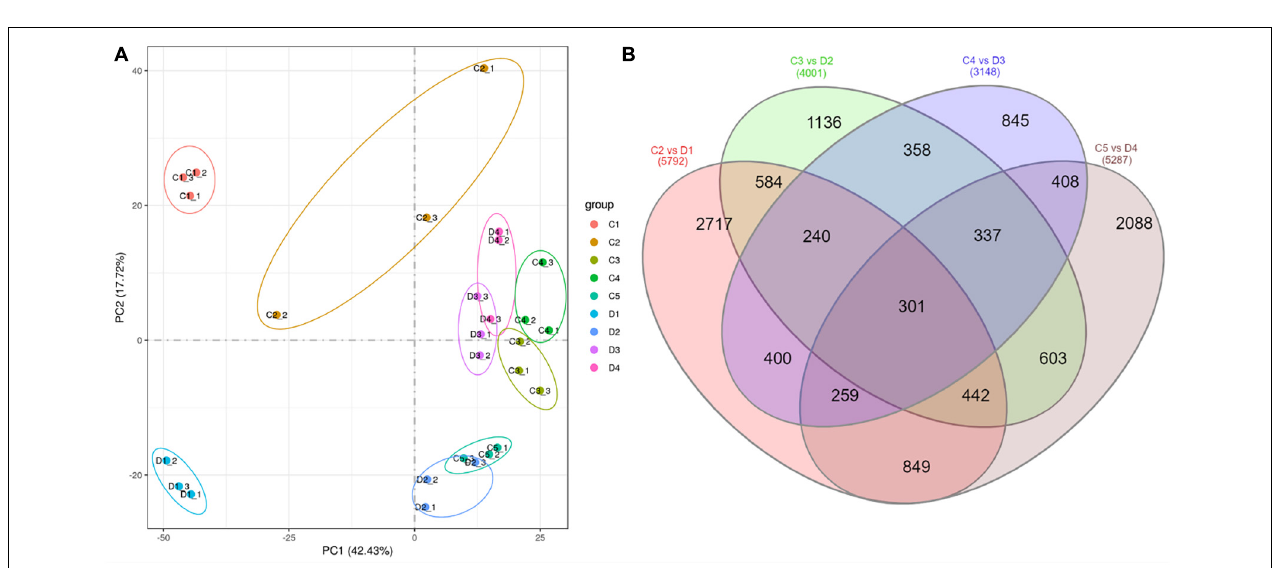
FIGURE 2 | (A) Principal component analysis of treatments of C (control group) and D (experiment group) of Citrus limon fruit peels, and (B) Venn diagram of differentially regulated genes by different treatment comparisons. C1, C2, C3, C4, and C5 represent the samples collected 30, 60, 90, 120, and 150 days after flowering. D1, D2, D3, and D4 represent the samples collected 60, 90, 120, and 150 days after flowering. The numbers 1, 2, and 3 with each treatment represent the three